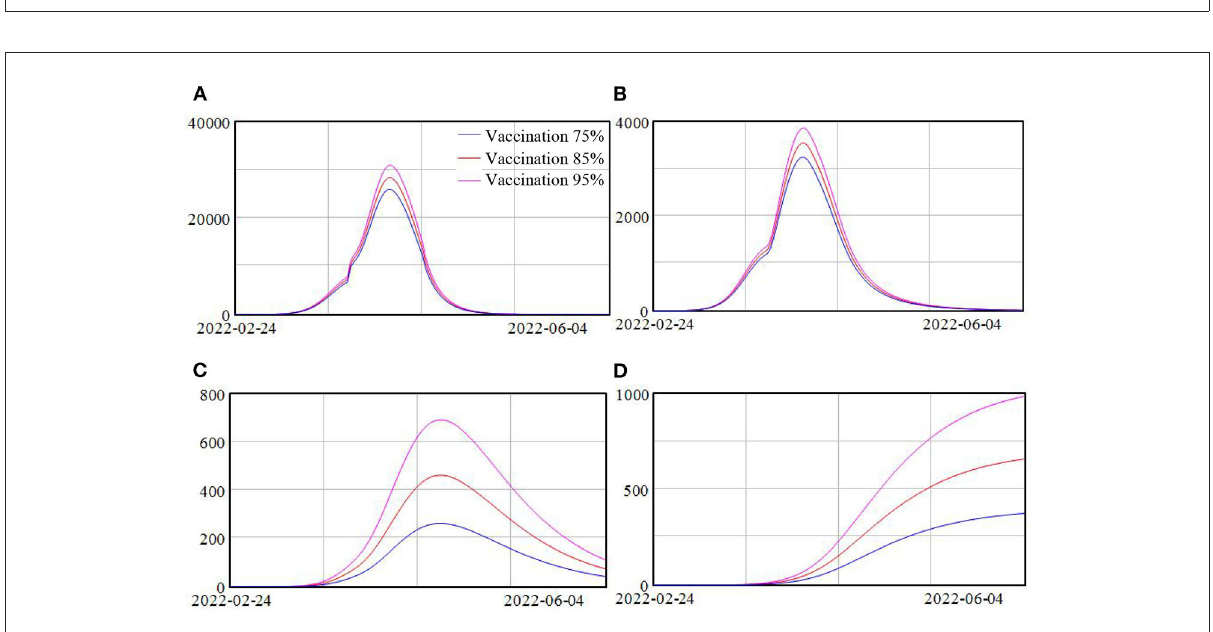
FIGURE5 (A–D) Model scenarios with different vaccination rate.